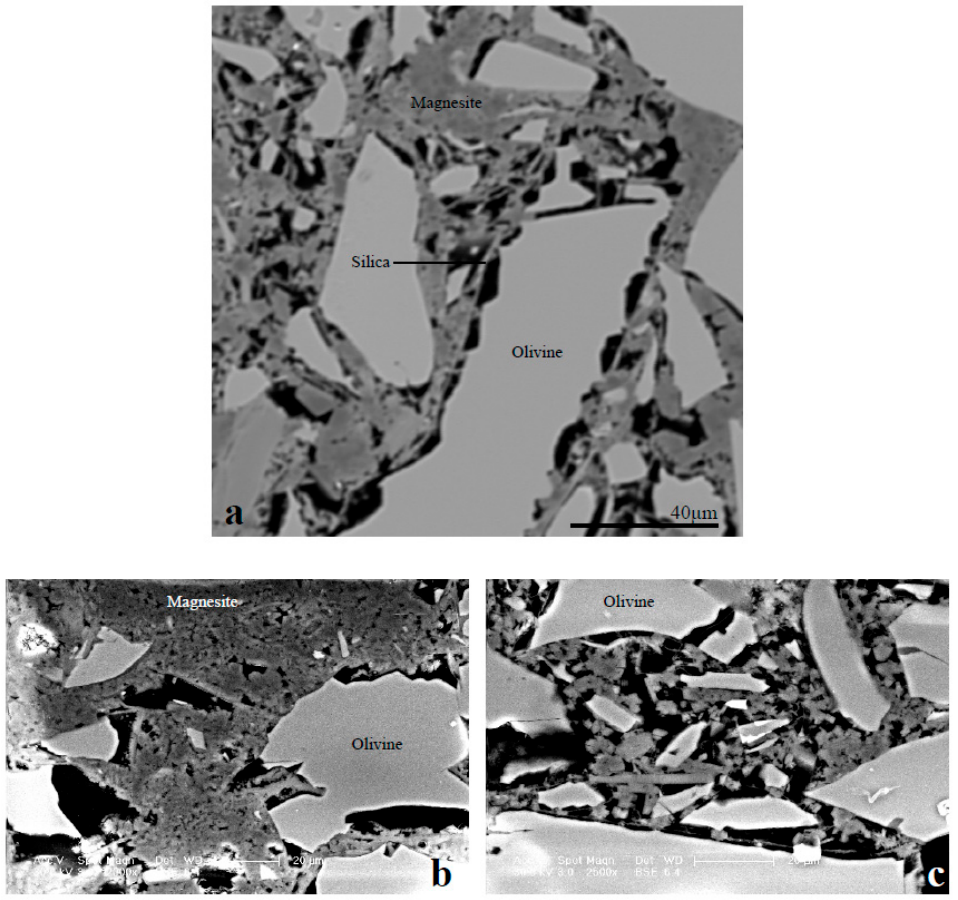
Figure 4. Microprobe ( a ) and SEM ( b , c ) images of reacted powder sample R0801. All images show a framework of olivine grains, with magnesite precipitating as very small grains and rough grain aggregates in the free pore space and on the olivine grain surfaces. In ( a ), notice the dissolution of olivine behind the precipitated layer of magnesite and silica (lighter areas in the precipitated layer) on the olivine grain surface, suggesting that dissolution continued after this layer was precipitated on the original grain surface. Images ( b , c ) show representative microstructures from the top and the bottom of the sample respectively, illustrating that magnesite precipitation was more prevalent at the top of the sample, leading to a much lower sample porosity there.